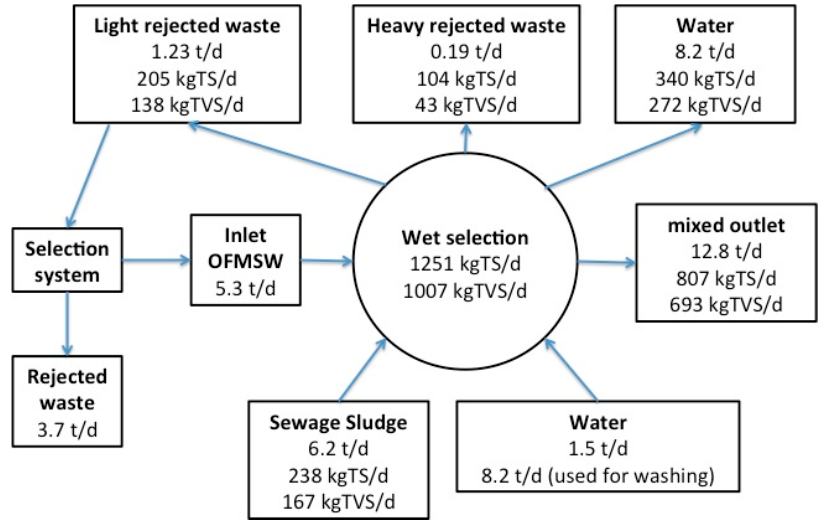
Figure 3. OFMSW mass balance during mechanical selection and wet refinery of Treviso plant (considering 9 ton day − 1 of food waste treated).